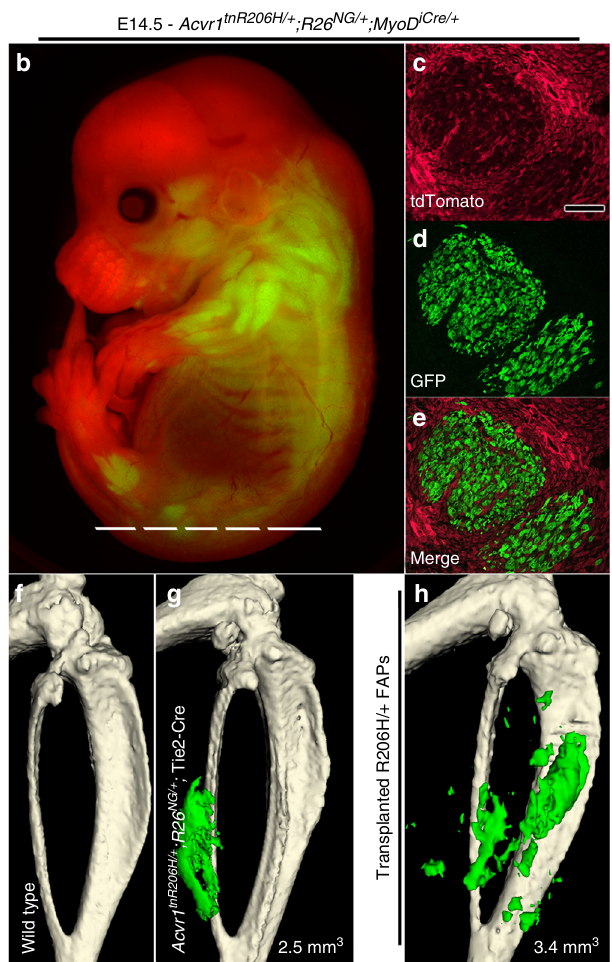
Fig. 1 Targeted recombination of Acvr1 tnR206H in FAPs causes HO.